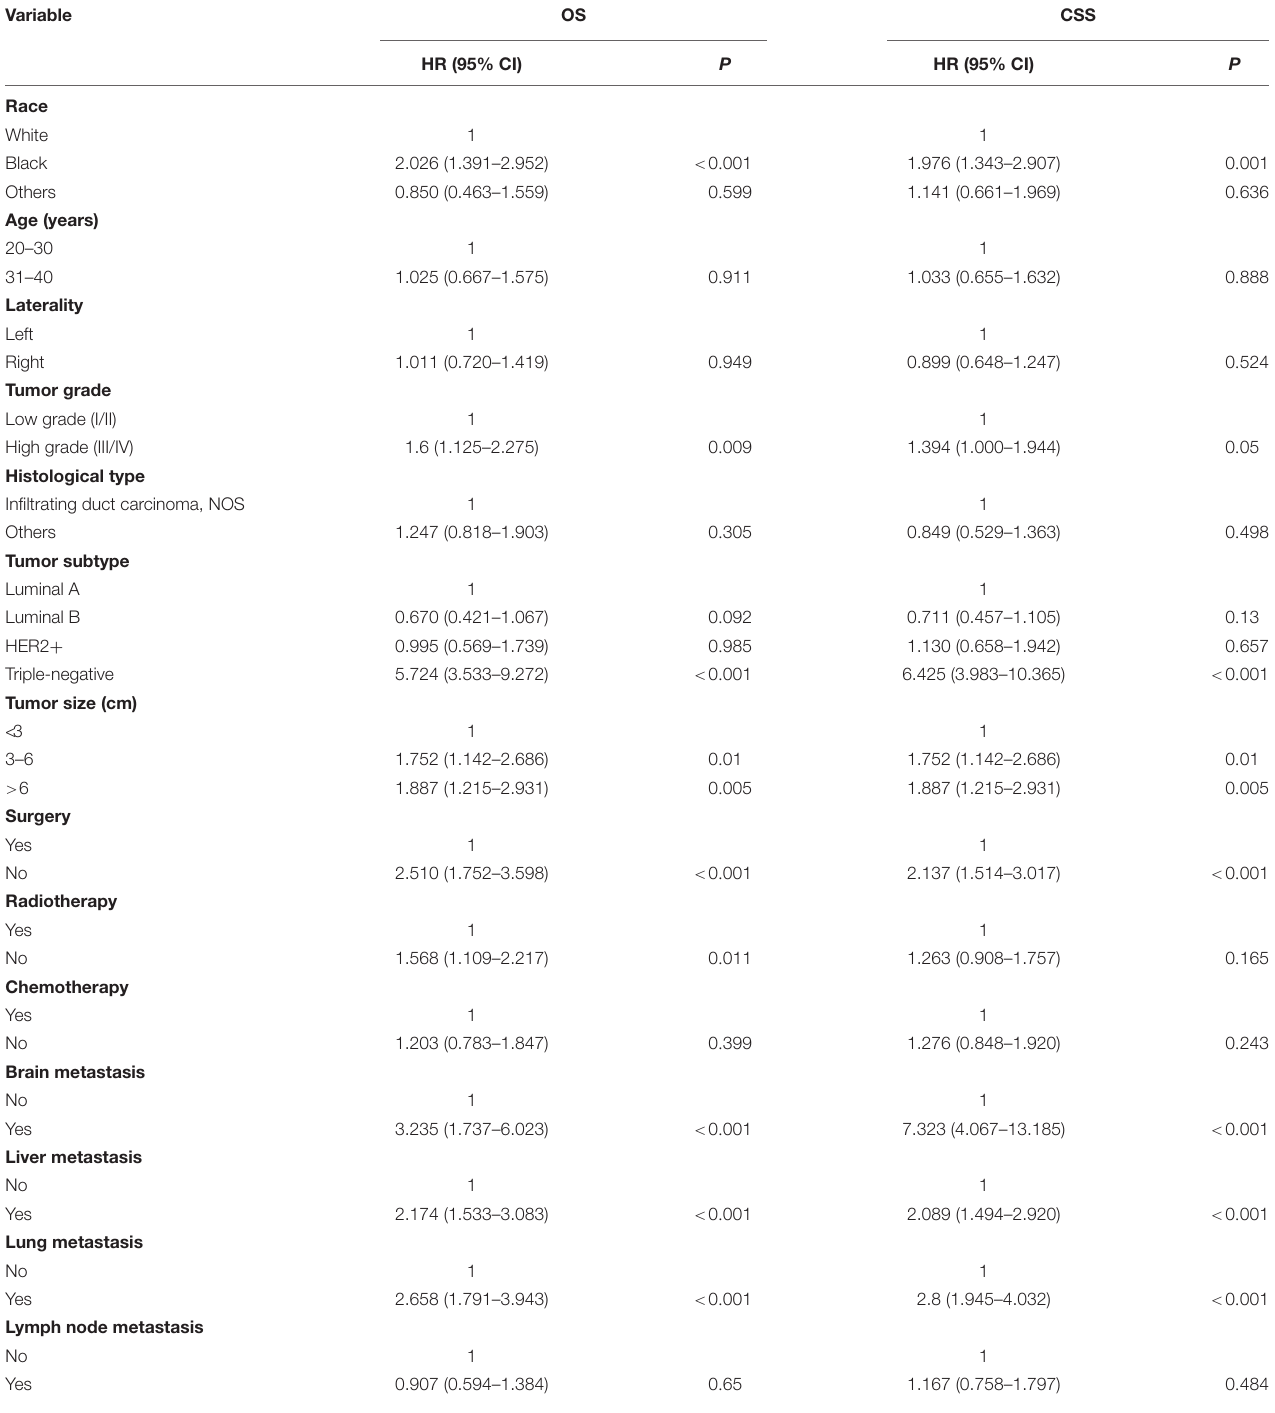
TABLE 2 | Univariate Cox analysis of survival in the training